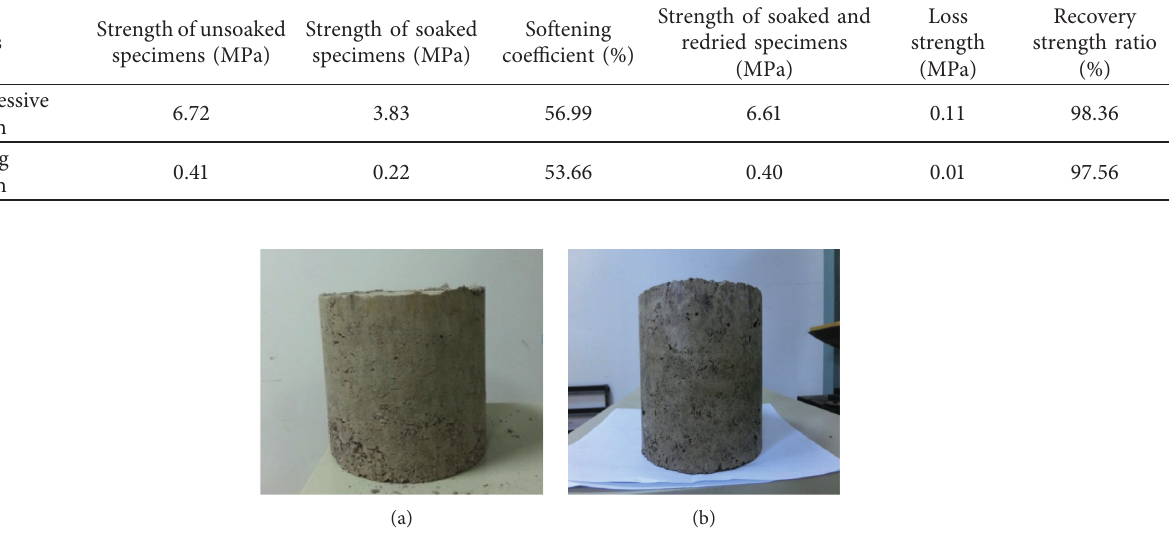
Figure 17: Appearance of the test specimen (a) before and (b) after dry-wet cycling. (a) Standard curing specimen. (b) Specimen of the fourth dry-wet cycling test.